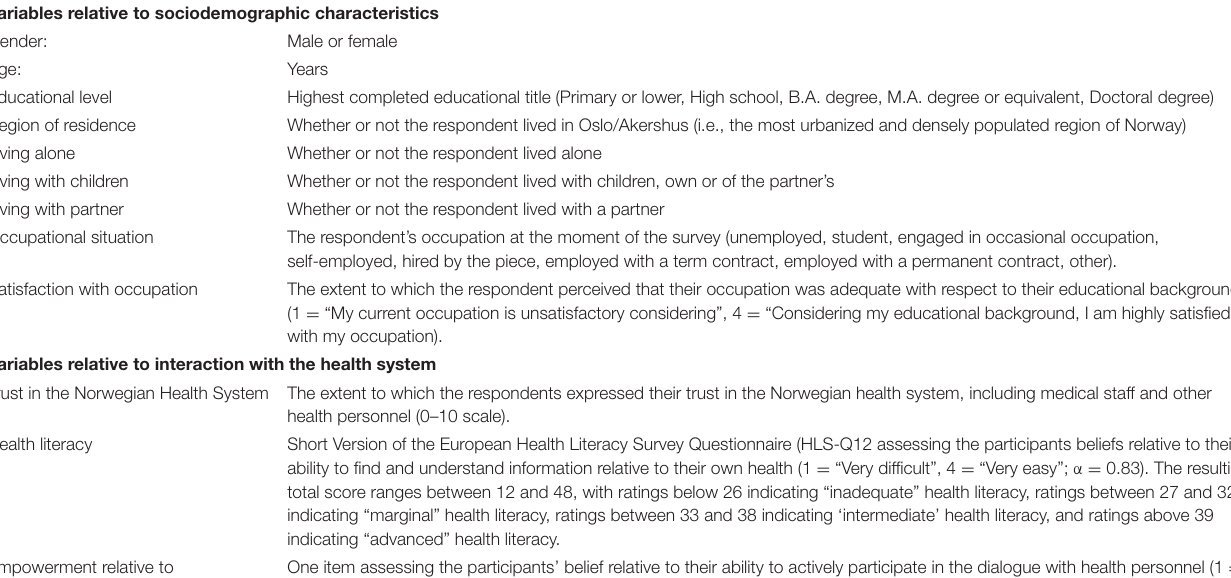
TABLE 1 | Predictors of Self-rated health included in the machine learning analysis. Variables relative to sociodemographic